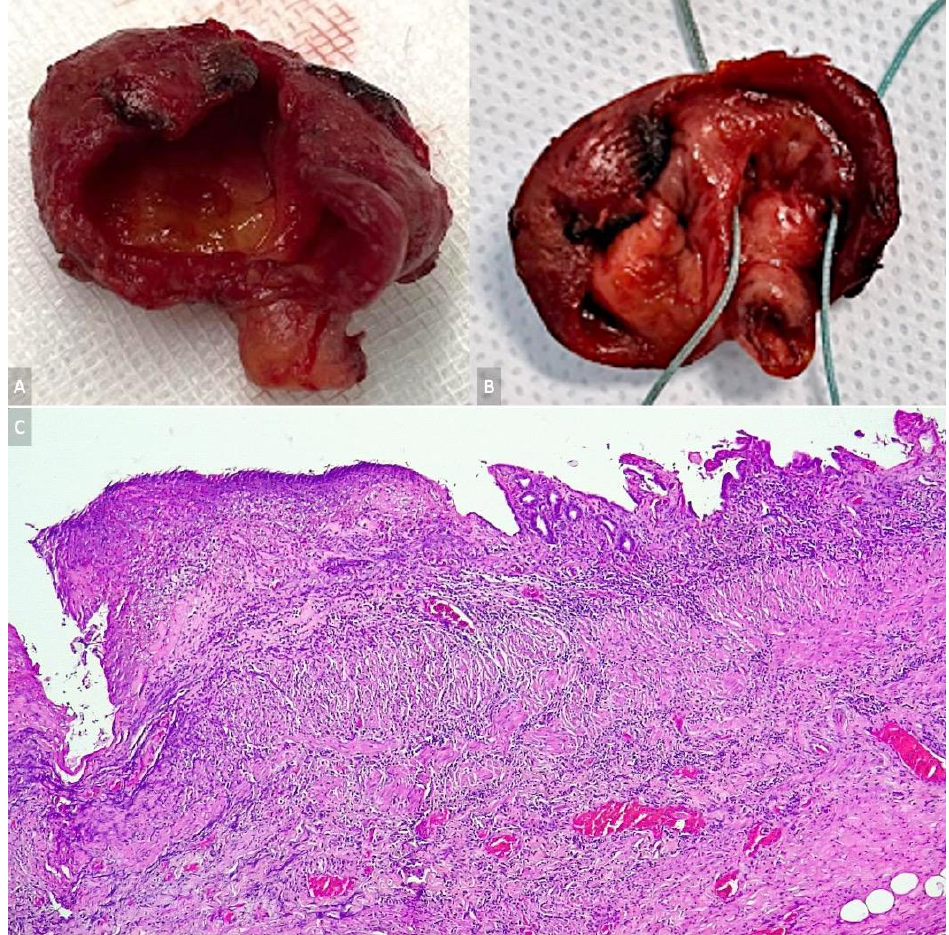
Figure 4. ( A , B ) Thick-walled fusiform dilatation of the biliary confluence; ( C ) biliary columnar epithelium of the CC with focal ulcerations and marked transmural polymorphic inflammatory infiltration.